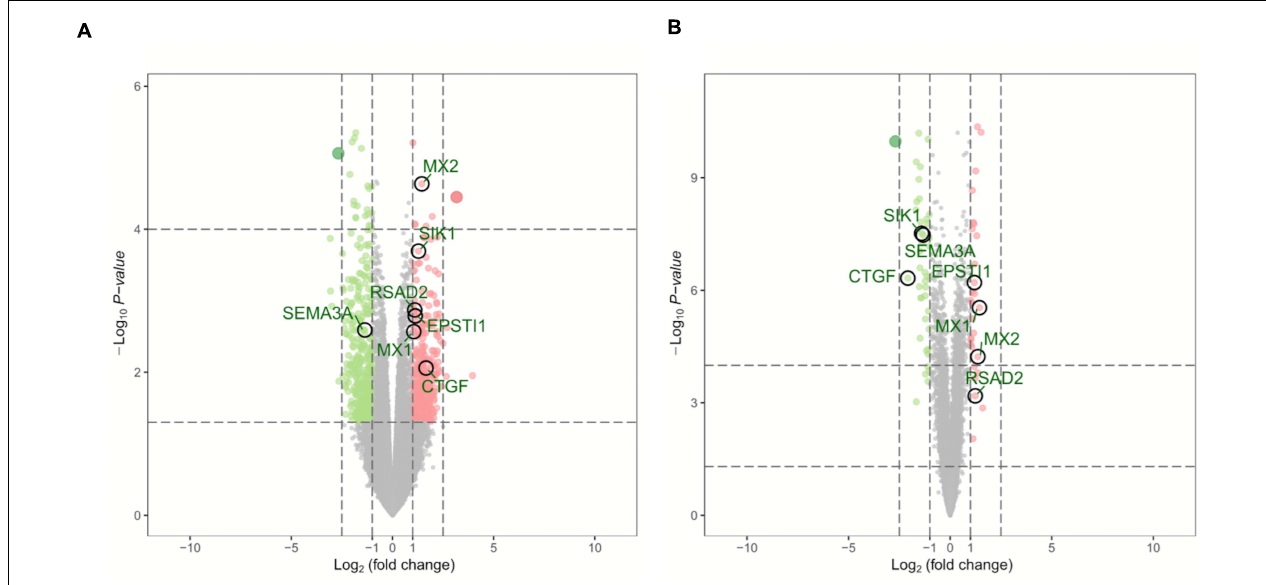
FIGURE 1 | Volcano plots of DEGs in GSE64052 and GSE76068. (A) DEGs in the GSE64052 dataset. (B) DEGs in the GSE76068 dataset. Red dots represent upregulated genes, and green dots represent downregulated genes. DEGs, differentially expressed genes.